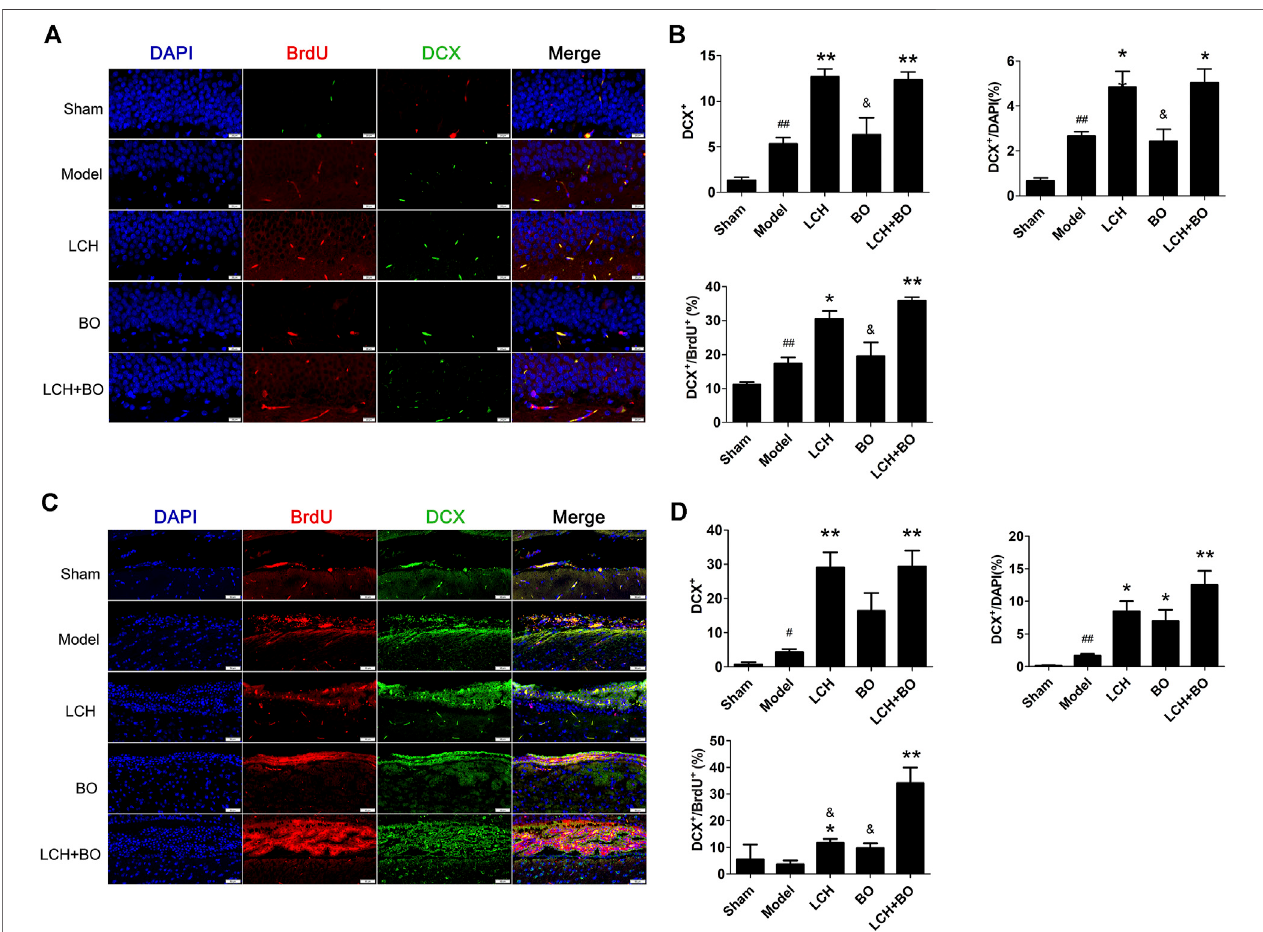
FIGURE 4 | Neurogenesis within DG and SVZ of MCAO rats. (A) Representative double-immunostaining images of DCX + /BrdU + in the DG area. (B) The results of DCX + cells, DCX + /DAPI, and DCX + /BrdU + in the DG area ( n (cid:1) 3). (C) Representative double-immunostaining images of DCX + /BrdU + in the SVZ area. (D) The results of DCX + cells, DCX + /DAPI, and DCX + /BrdU + in the SVZ area ( n (cid:1) 3). # p < 0.05, ## p < 0.01 compared to the sham group; * p < 0.05, ** p < 0.01 compared to the model group; & p < 0.05 compared to the LCH + BO